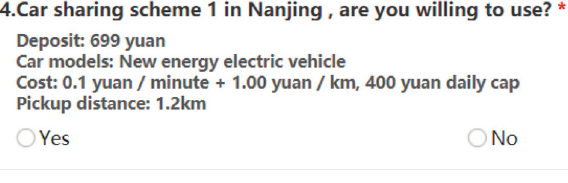
Figure 1: Questionnaire of car-sharing plan one.